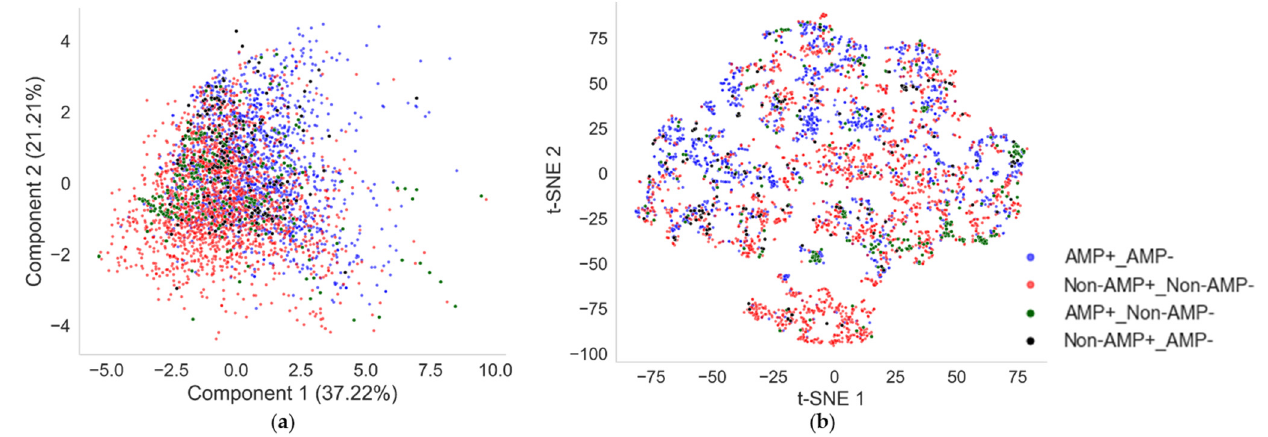
Figure 5. PCA ( a ) and t-SNE ( b ) projections of physicochemical descriptors between common peptides of Gram+ and Gram − categories. In blue are peptides are labelled as AMP in both categories, in red are peptides are labelled as Non-AMP in both categories, in green are peptides labelled AMP for Gram+ and Non-AMP for Gram − , and in black is the opposite.